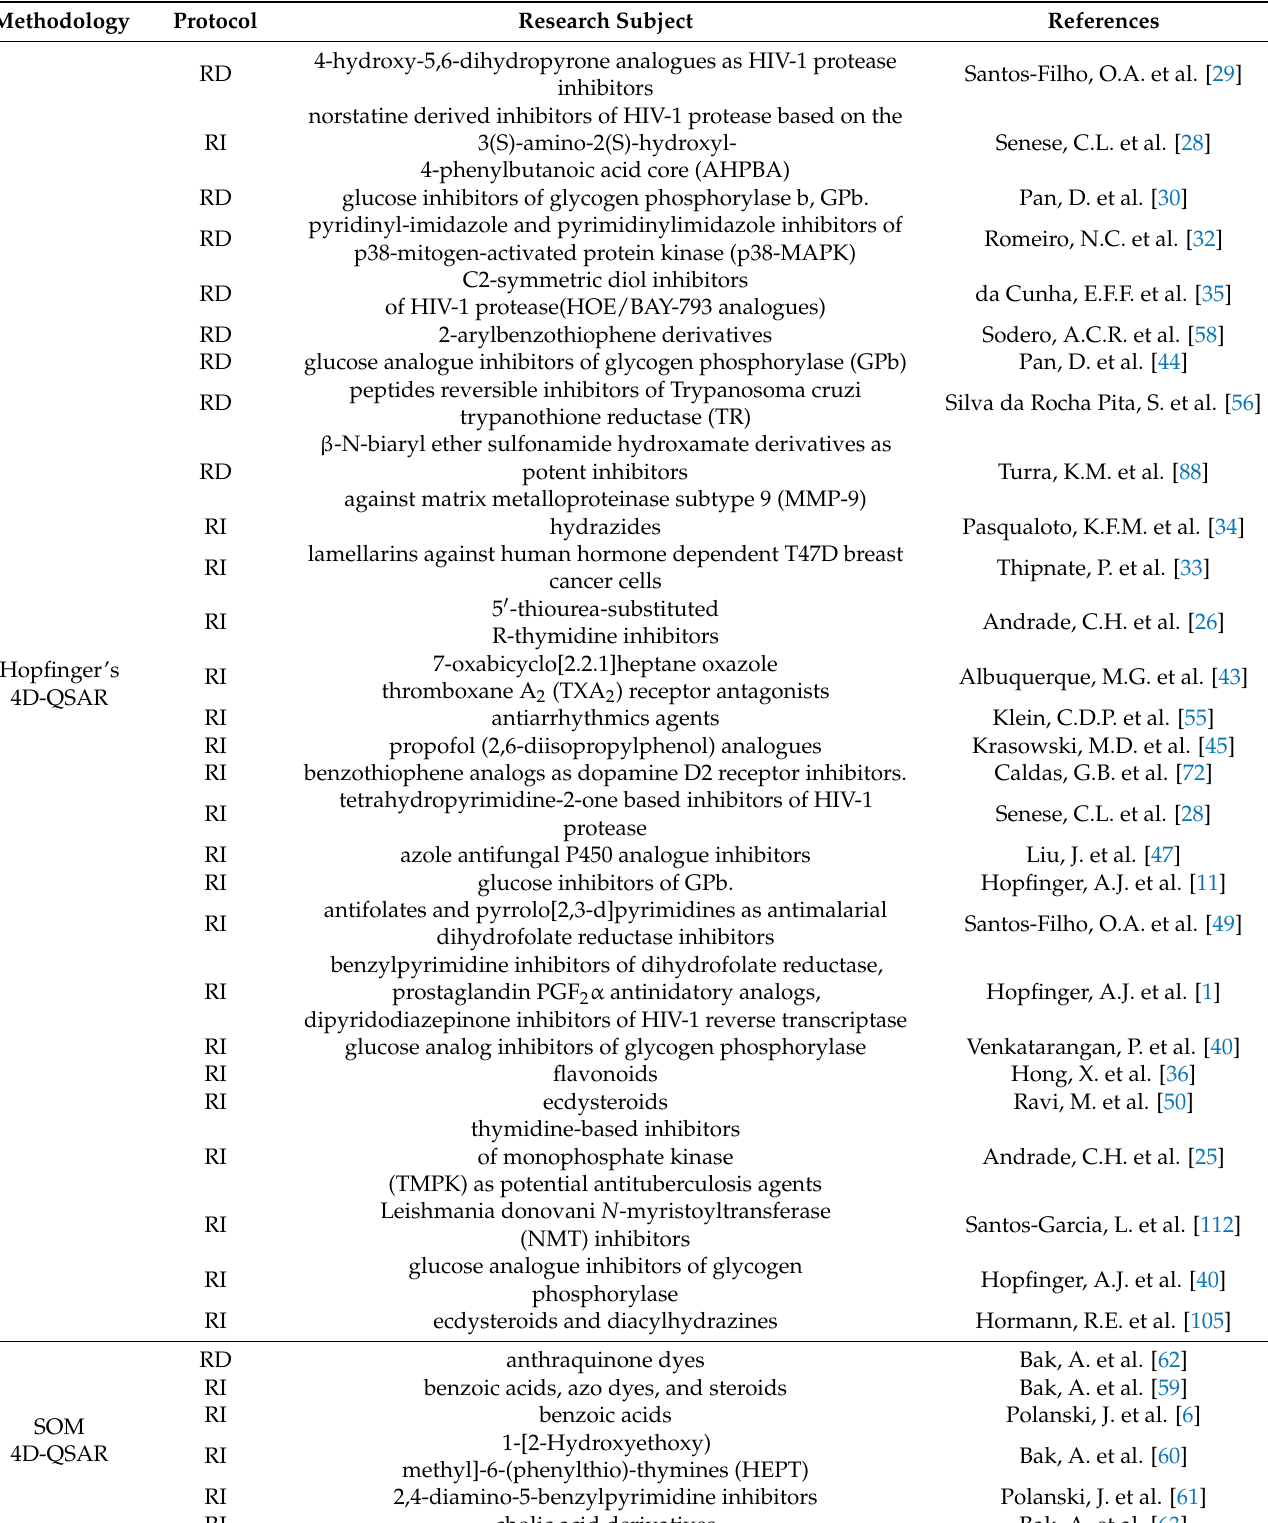
Table 1. Brief characterization of 4D-QSAR protocols, research projects with